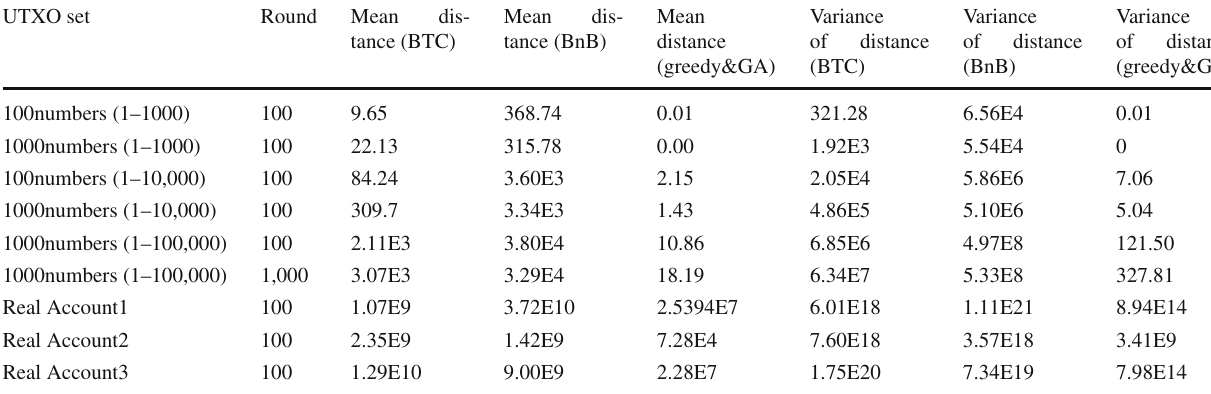
Table 1 Results of bitcoin transaction selection methods (distance)